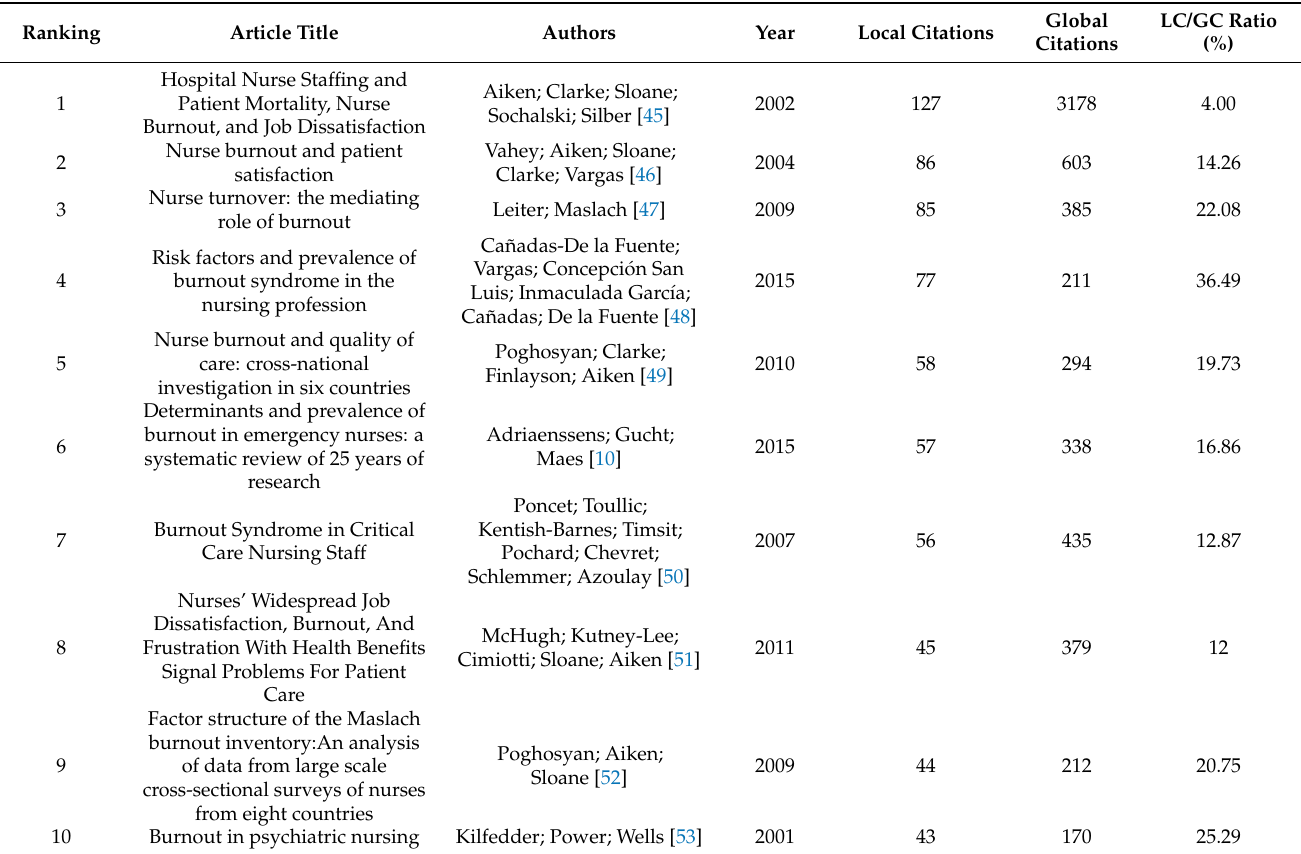
Table 3. Top 10 most global and local cited